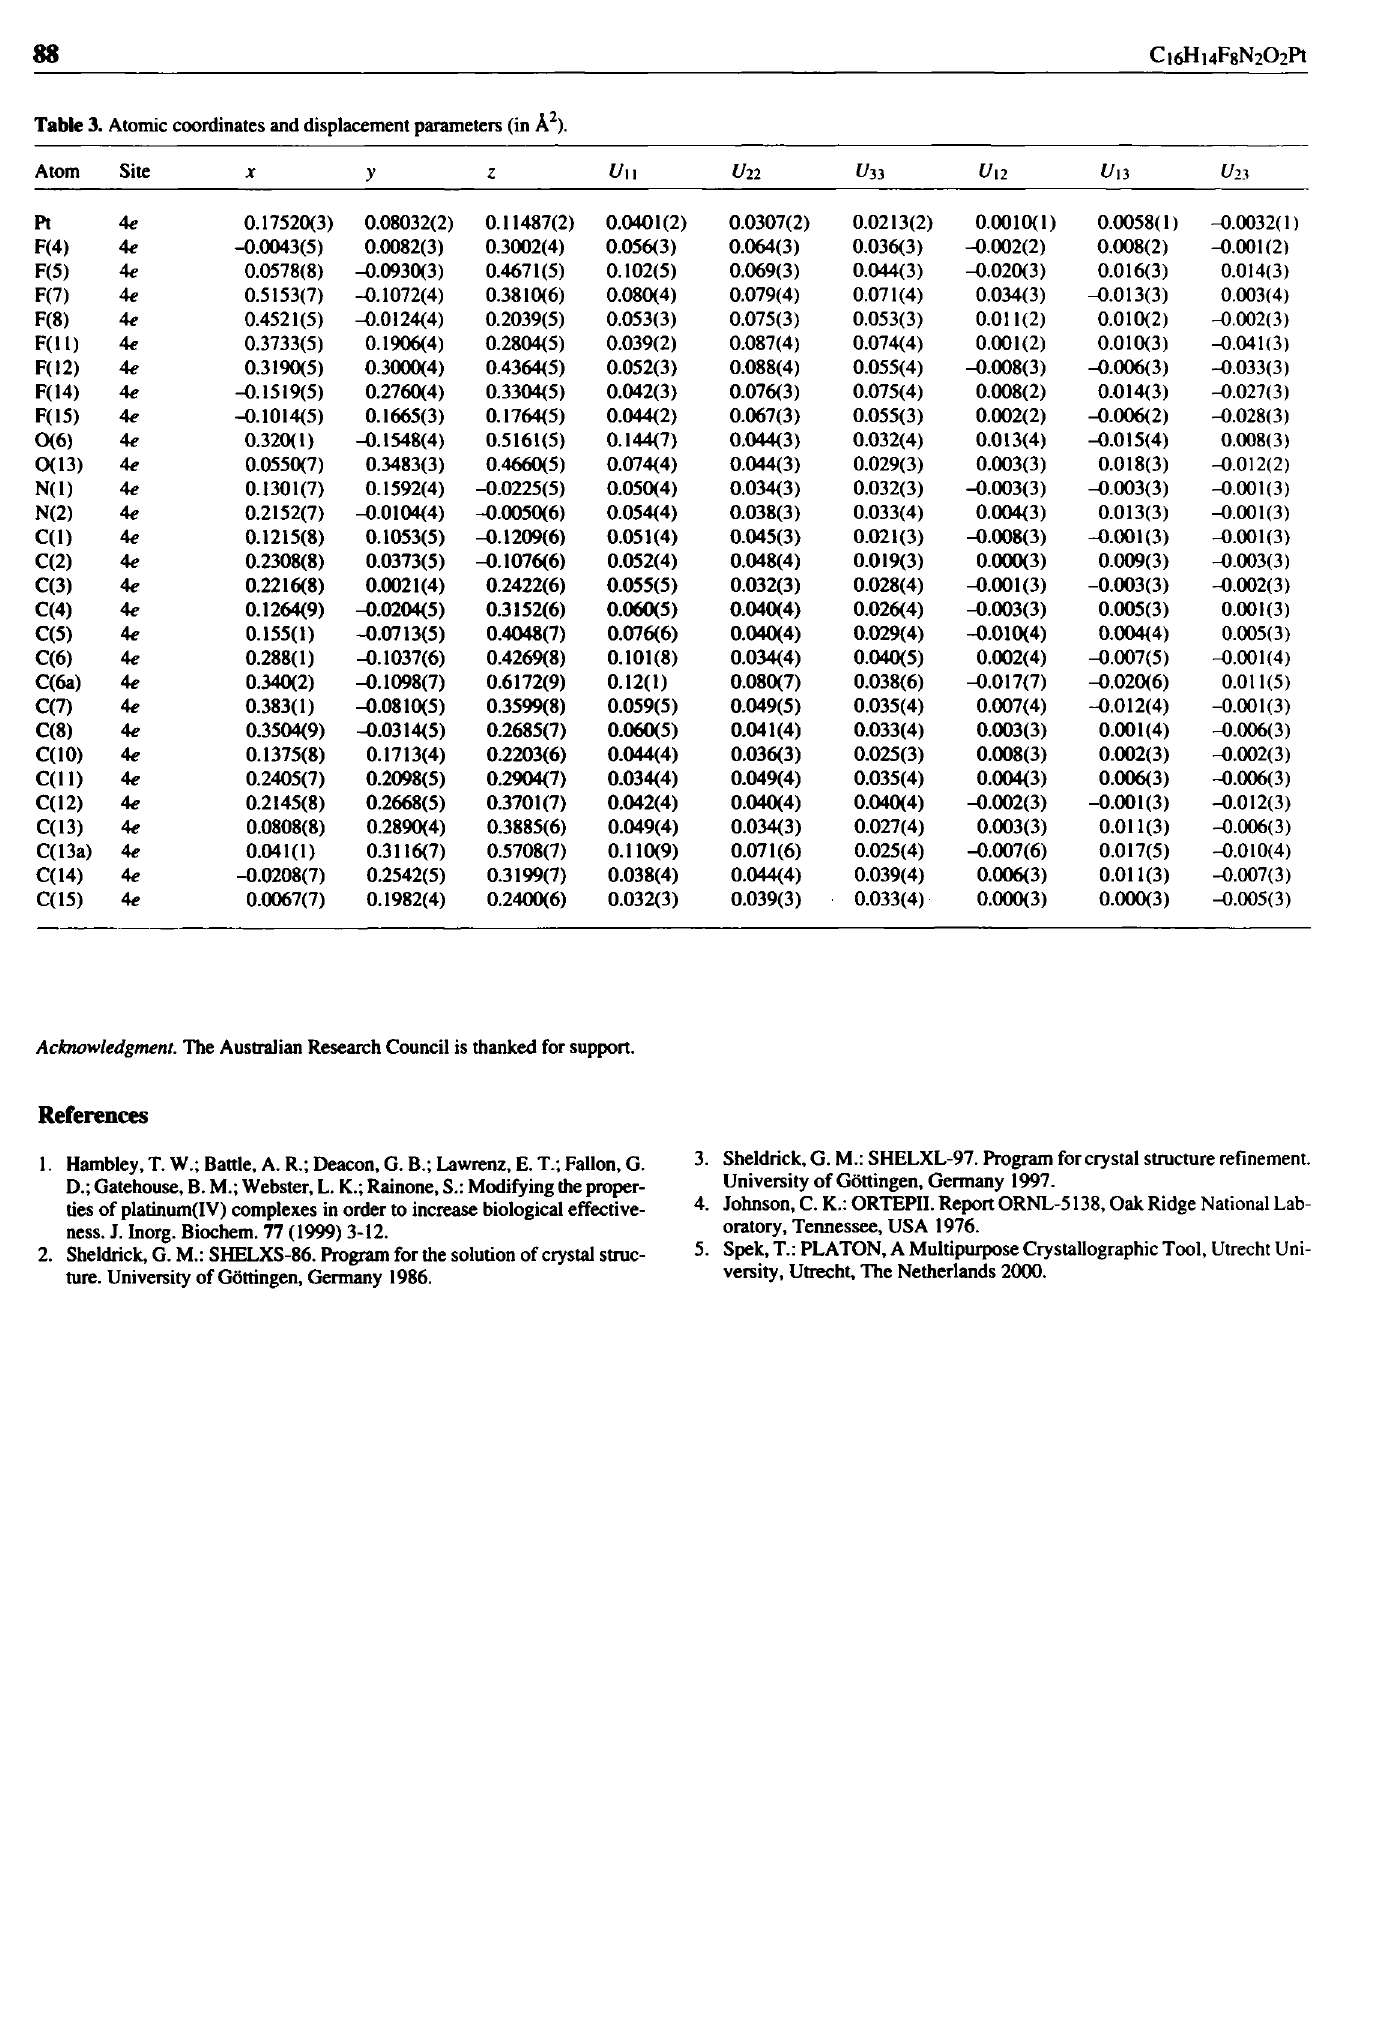
Table 3. Atomic coordinates and displacement parameters (in À 2